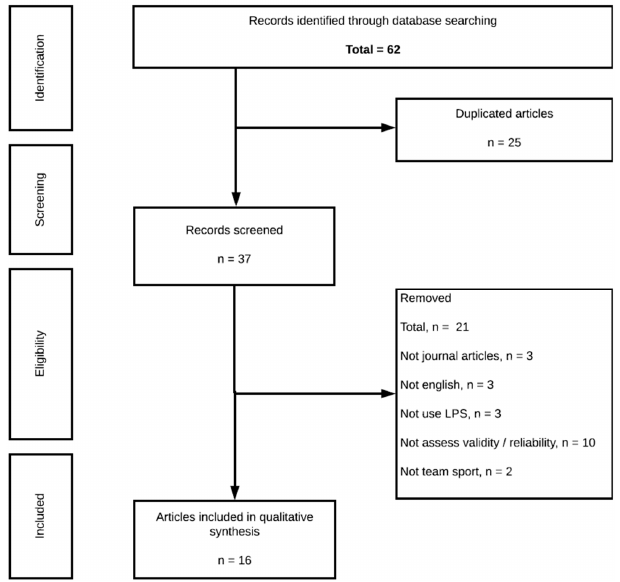
Figure 1. Flow diagram of the study.